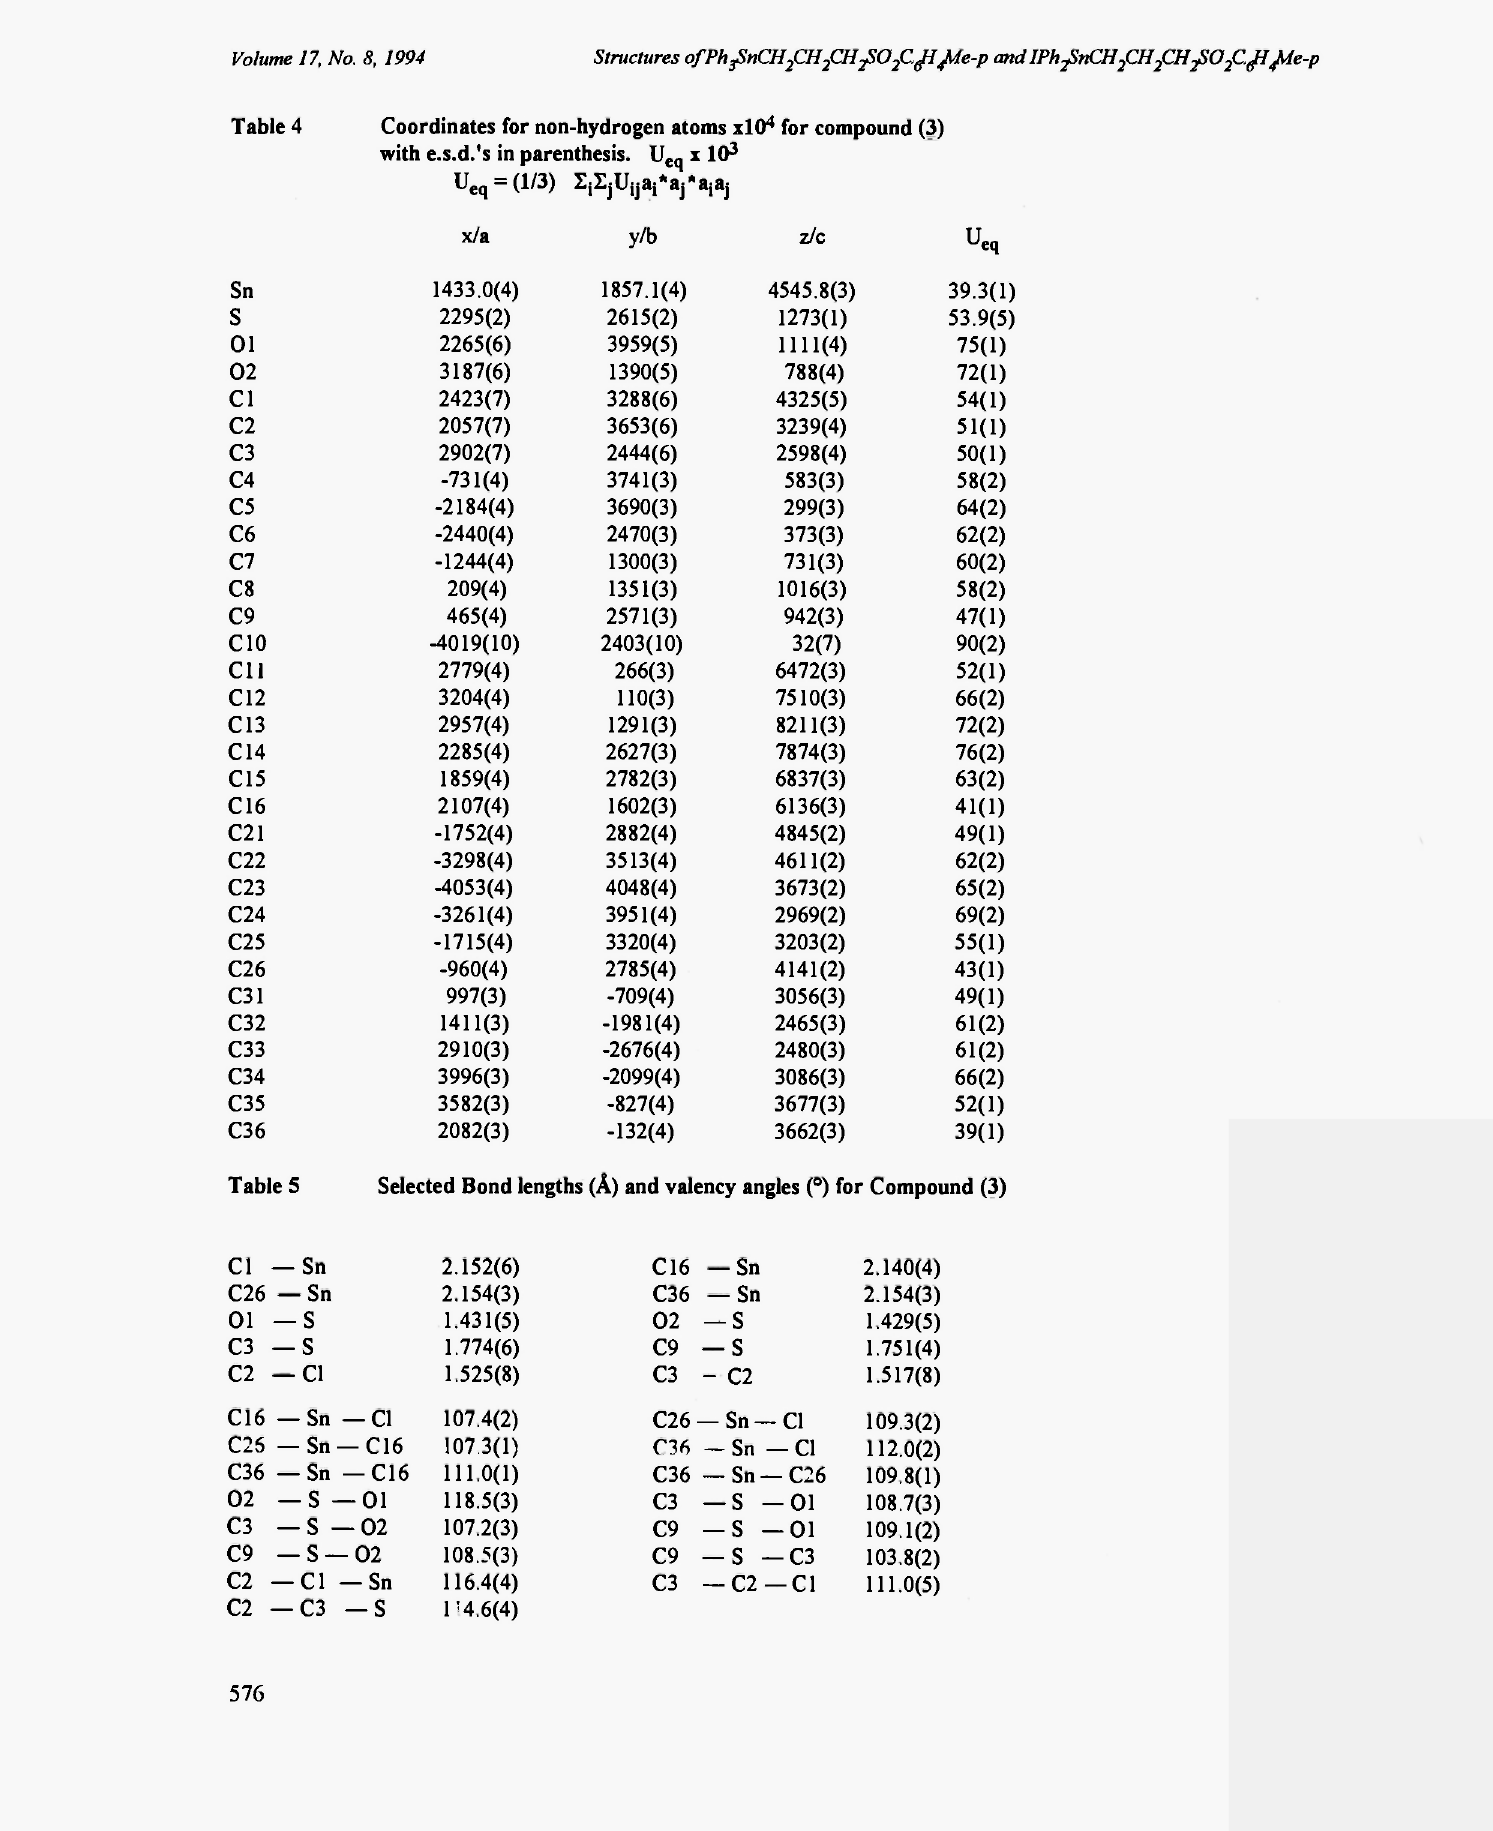
Selected Bond lengths (Ä) and valency angles (°) for Compound